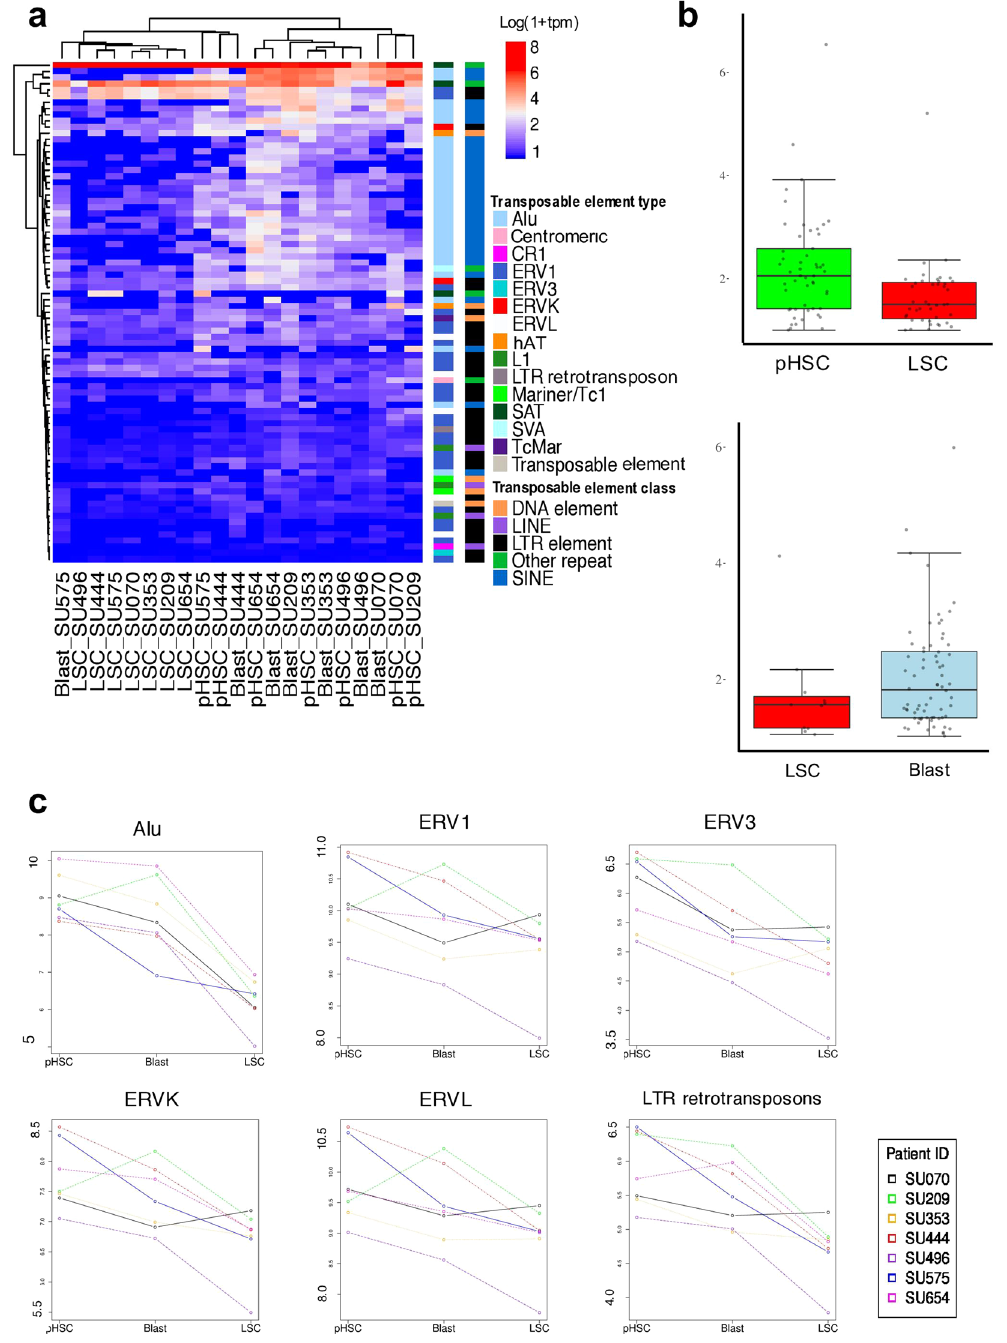
Figure 1. Analysis of differential expression of transposable elements in pre-leukemic stem cells (pHSC), leukemic stem cells (LSC), and Blasts ( a ) X-axis; Patient identifier. The expression levels in log10 using the metric transcripts per million (TPM). The ‘Transposable Element (TE) Type ‘ classifies individual repeat transcripts into one of 68 unique canonical categories of TEs. Each TE type is contained in one TE Class. ( b ) Quantiles of the absolute log-fold change of the differentially expressed (DE) TE transcripts in pHSC-LSC, and Blast-LSC samples. Y-axis: absolute log-fold change of each individual DE TE transcript from Fig. 1A. ( c ) Y-axis: log10 of TPM expression level for each of the 7 paired samples across each clonal point. The individual patients are denoted with unique